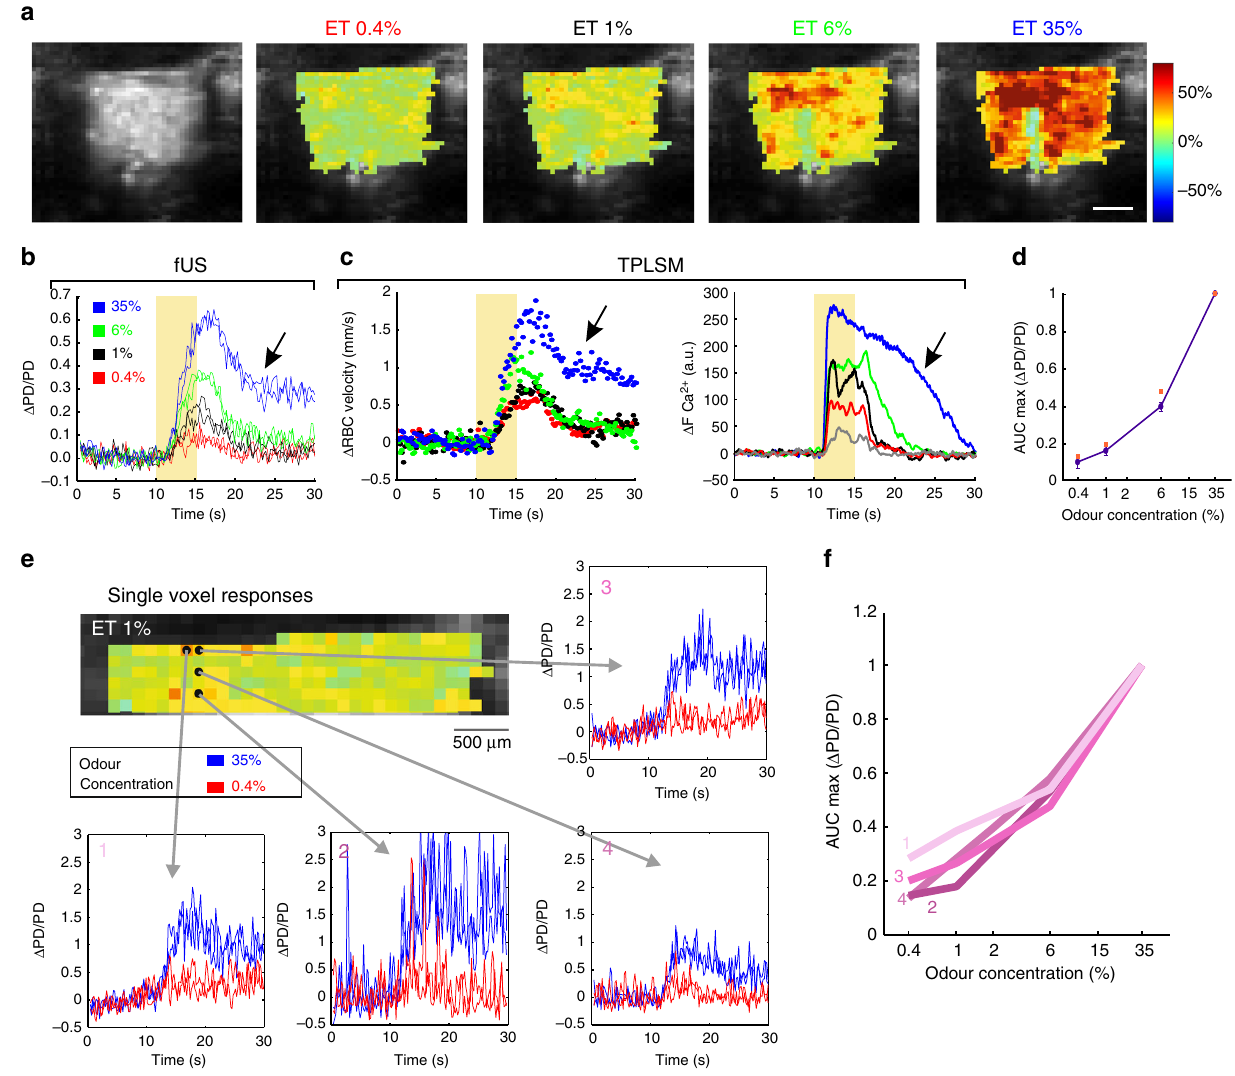
Fig. 4 Comparison of mesoscopic (fUS Power Doppler) and microscopic (TPLSM) responses to odour. a Spatial distribution Δ PD/PD voxel values at increasing concentrations of odour (ET). Maps are superimposed onto a background image of the tissue signal (see Methods). Averages of three inhalations. Scale bar: 1 mm. b Time course of the global Δ PD/PD signal comprising all voxels (two trials are superimposed at each concentration). c RBC velocity (left) and neuronal Δ Ca 2 + (right) responses to odour in the same animal as a , b . Baseline RBC velocity: 1.25 mm/s. Traces represent mean of 2 – 3 trials. Note the similarity between the global fUS and single capillary RBC velocity response. Arrows ( b , c ) indicate prolonged neuronal and vascular activation at high odour concentration. d Semi-log plot of Δ PD/PD AUC maxima vs. odour concentration. Values are normalized to the maximum value (35% odour, n = 5 mice). Orange squares represent the mouse data from panel ( b ). e Δ PD/PD responses are detectable at the level of single voxels. Top left: dorsal region of a at 1% ET, showing upper seven voxel layers. For the four voxels, two trials are superimposed at two concentrations: 0.4% (red) and 35% (blue). f Semi-log plot of Δ PD/PD AUC maxima vs. odour concentration for each voxel (average of three inhalations, normalized to 35% ET).